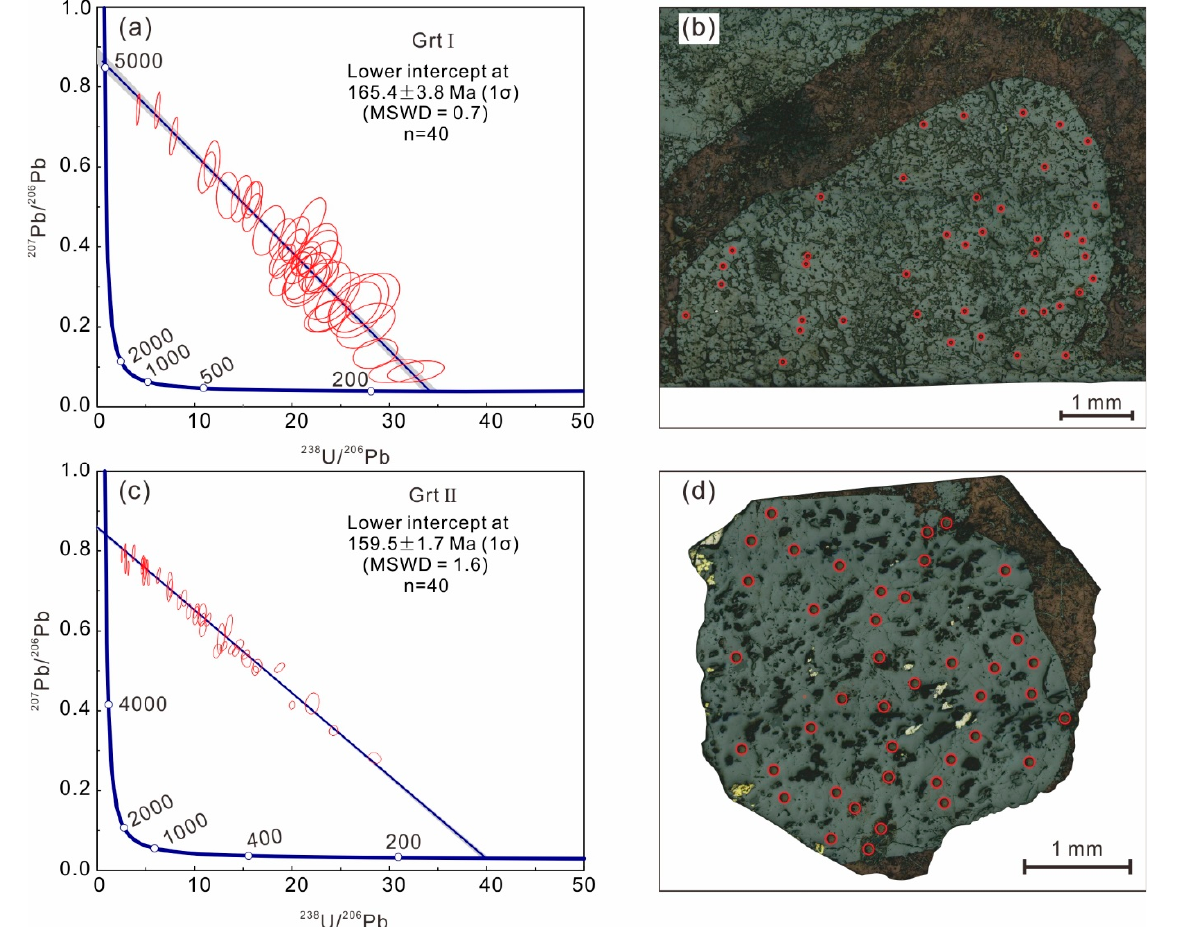
Figure 10. Results of U-Pb dating of garnet from the Tongshanling deposit: ( a ) U-Pb data synergy diagram of Grt I, ( b ) U-Pb dating analysis point of Grt I, ( c ) U-Pb data synergy diagram of Grt II, ( d ) U-Pb dating analysis point of Grt II.